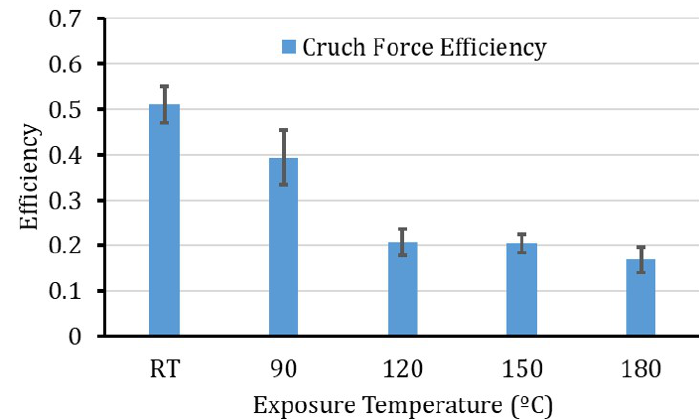
Figure 8. Crush force efficiency of the specimens at different exposure temperatures.